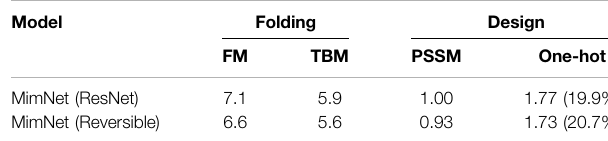
TABLE 3 | A comparison of the reversible and standard ResNet architectures on folding and design tasks on CASP 11. For the folding task, we report both FM and TBM proteins dRMSD (Å) scores. For the design task, the KL-divergence of the PSSM and sequence (one-hot labels) are reported, along with the sequence prediction